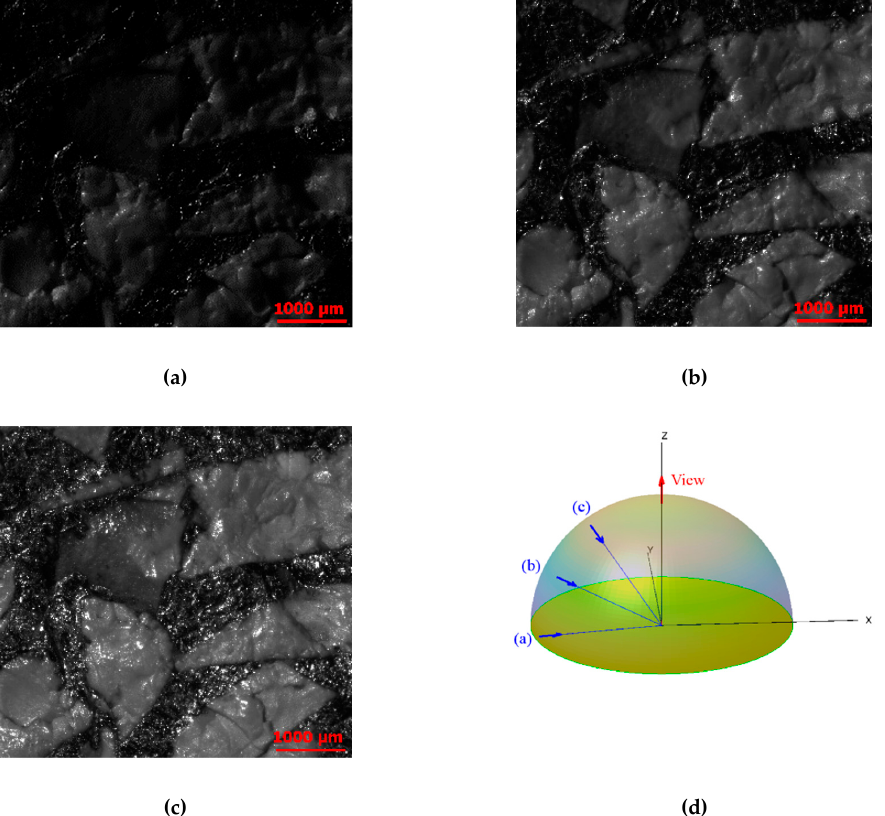
Figure 7. Reflectance images at ϕ = 215°. Θ = 80° ( a ), θ = 57.5° ( b ), θ = 35° ( c ), and reflectance halfsphere ( d )